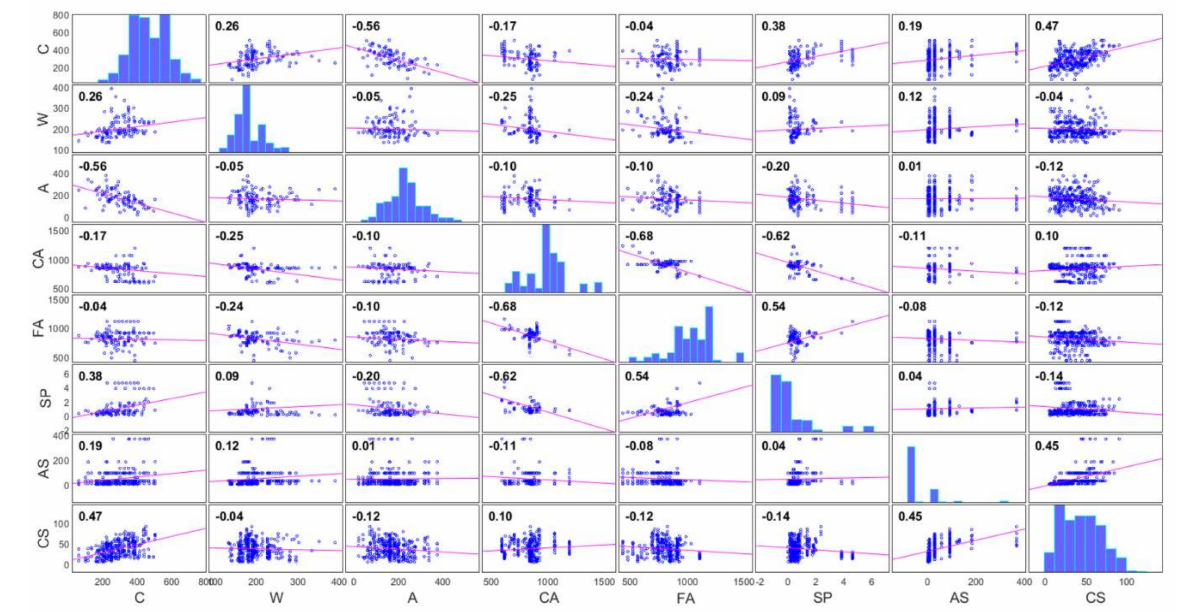
Figure 10. Correlation matrix of model variables. Table 2. Statistical properties of variables used for